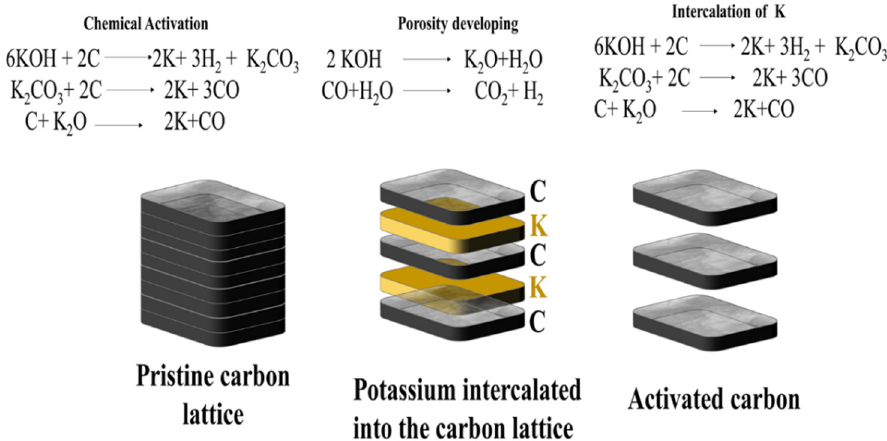
Figure 3. Activation mechanism by the intercalation of metallic K into the pristine carbon lattices, the expansion of the lattices by the intercalated metallic K, and the removal of the intercalated K from the carbon matrix adapted from [49].